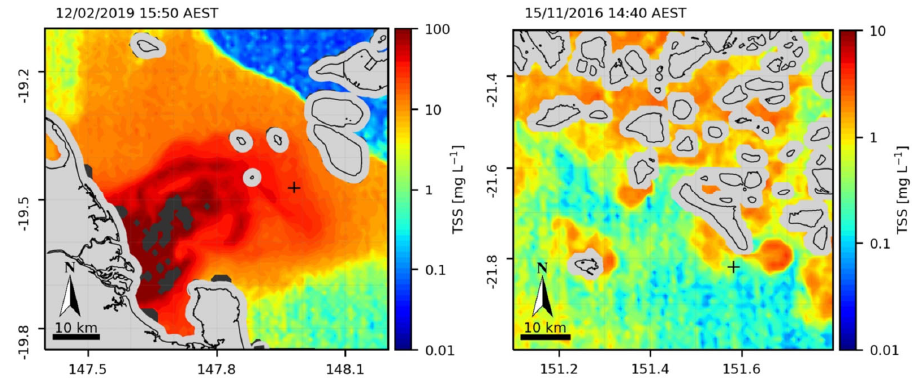
Figure 7. Flood plume discharging from the Burdekin River, February 2019 ( left panel ). TSS tidal jets within the GBR reef matrix in November 2016 ( right panel ). Note the different ranges in each plot. Pixels masked in black are due to out-of-range TSS values.